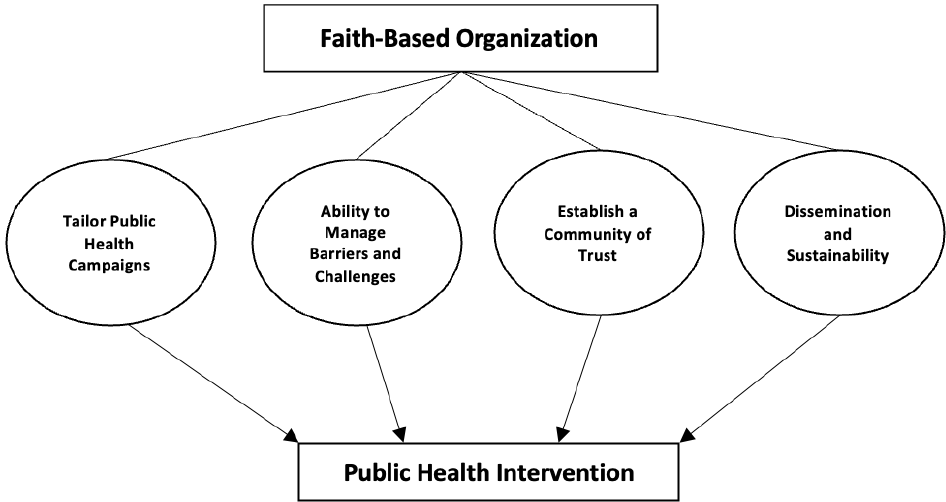
Figure 2. Theoretical Framework of the Role of Faith-Based Organization. Table 1. Summary of Published Studies Focused on the Role of Faith Based Organizations in Public Health Campaigns and Efforts.